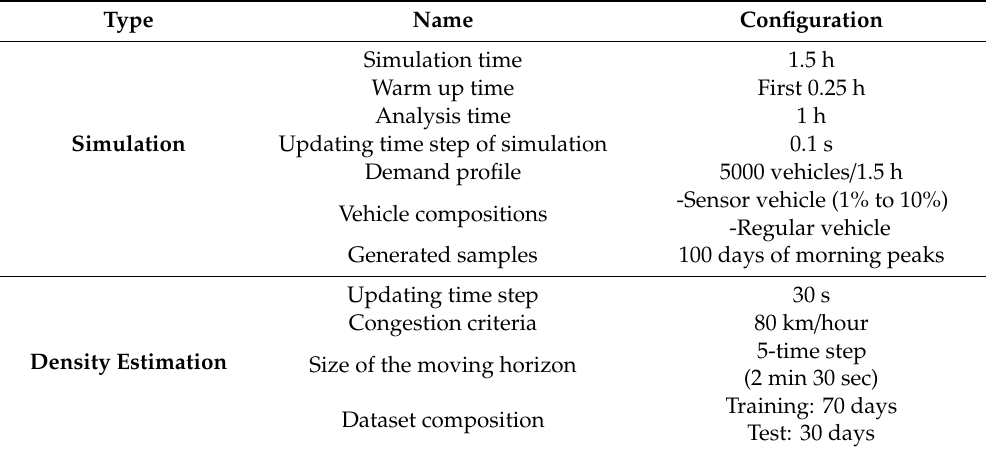
Table 3. Configuration for performance